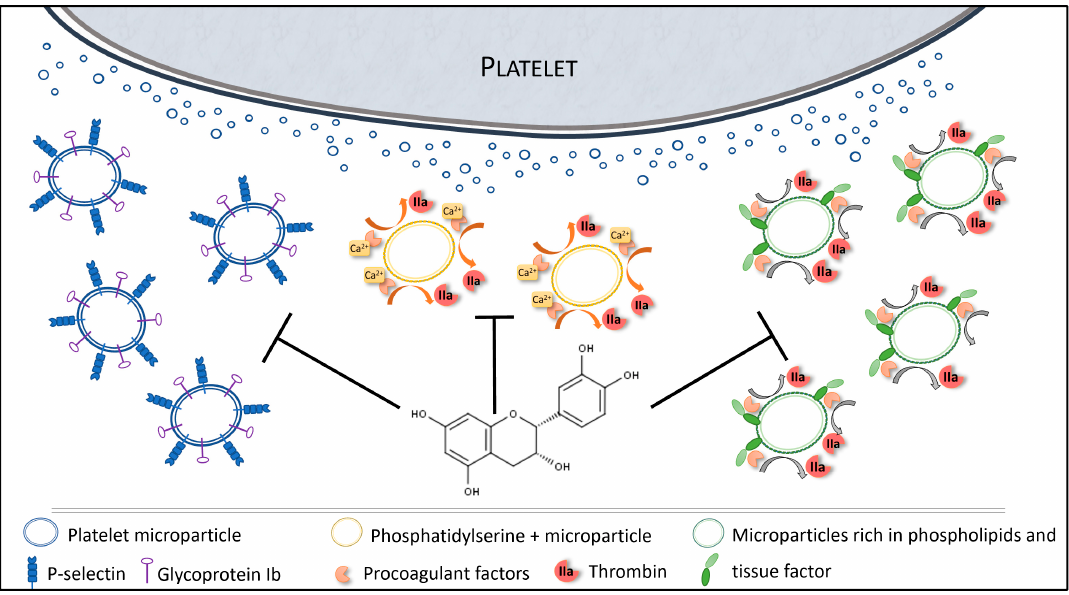
Figure 6. Overview of the impacts of epicatechin on microparticles.